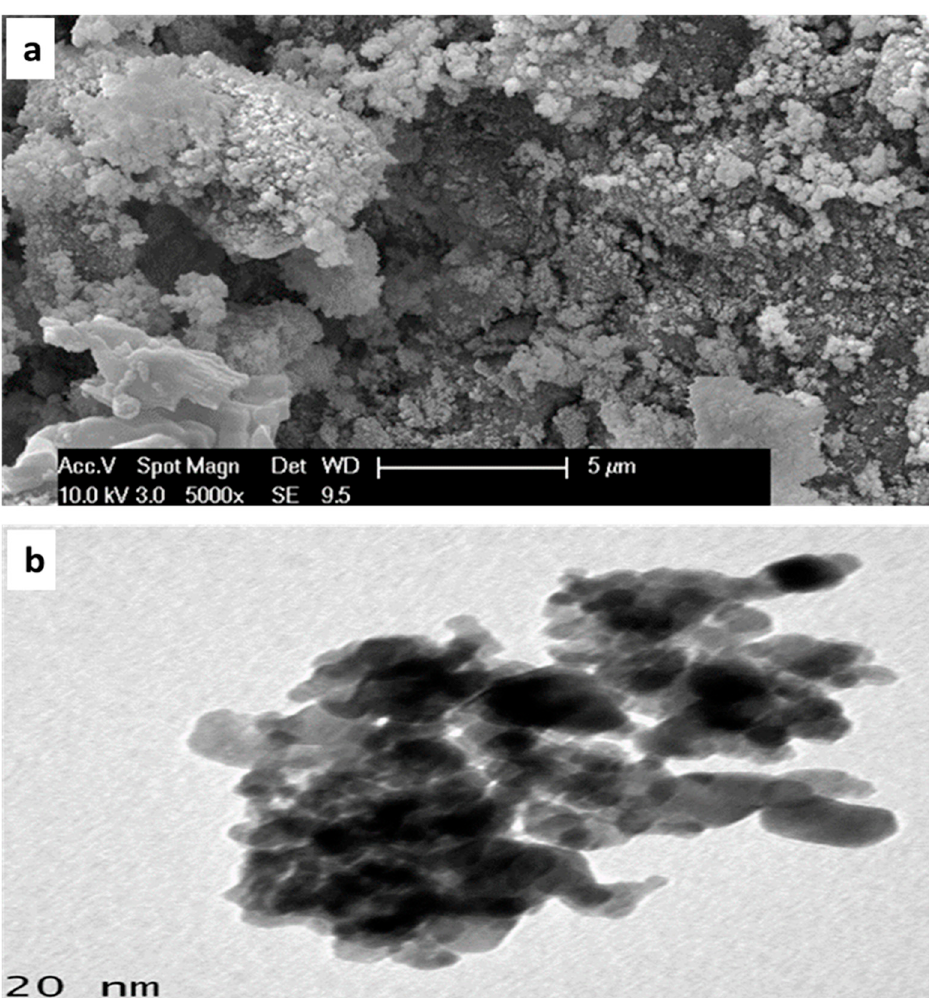
Figure 4. Micrographs of fresh NiFe 2 O 4 ( a ) scanning electron microscopy (SEM) and ( b ) transmission electron microscopy (TEM).